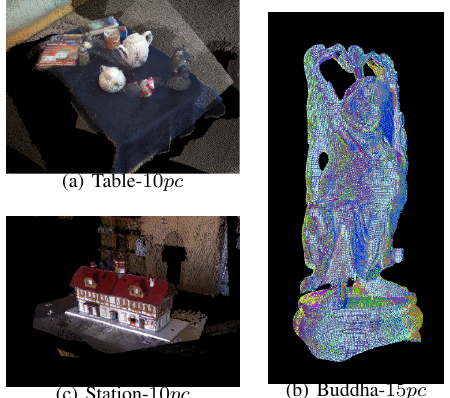
Figure 11: Example datasets